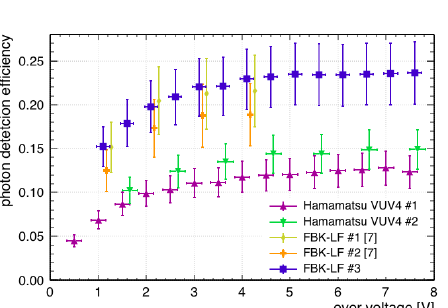
Figure 2: Photon Detection E ffi ciency (PDE) as a function of the over voltage for two Hama- matsu VUV4 MPPCs and three FBK-LF SiPMs. The error, on each point, for all the five devices accounts for the presence both to the statistical and the systematic